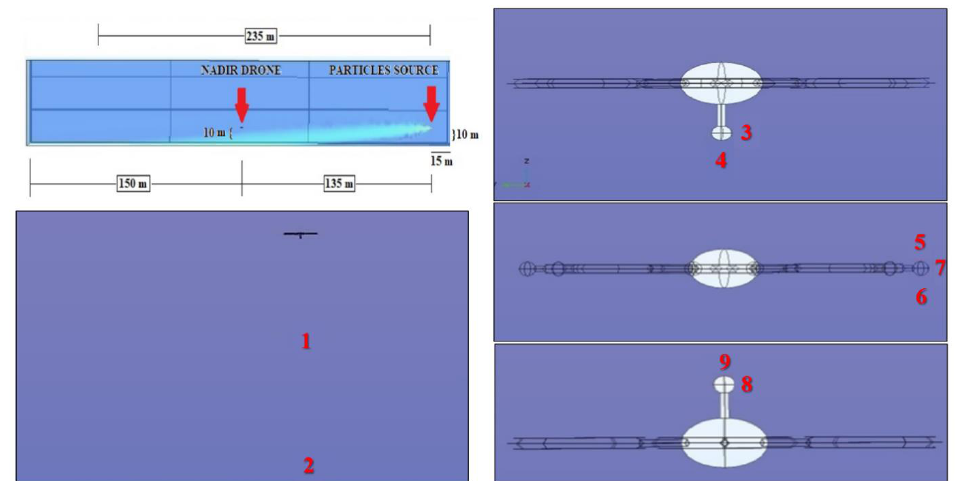
Figure 8. Schematics of the drone-sphere geometry, concentration field, and point analyzed in the numerical set 10-135-10.